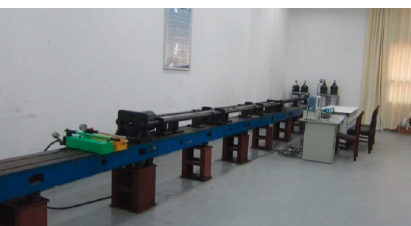
Figure 3: Split Hopkinson pressure bar test system.